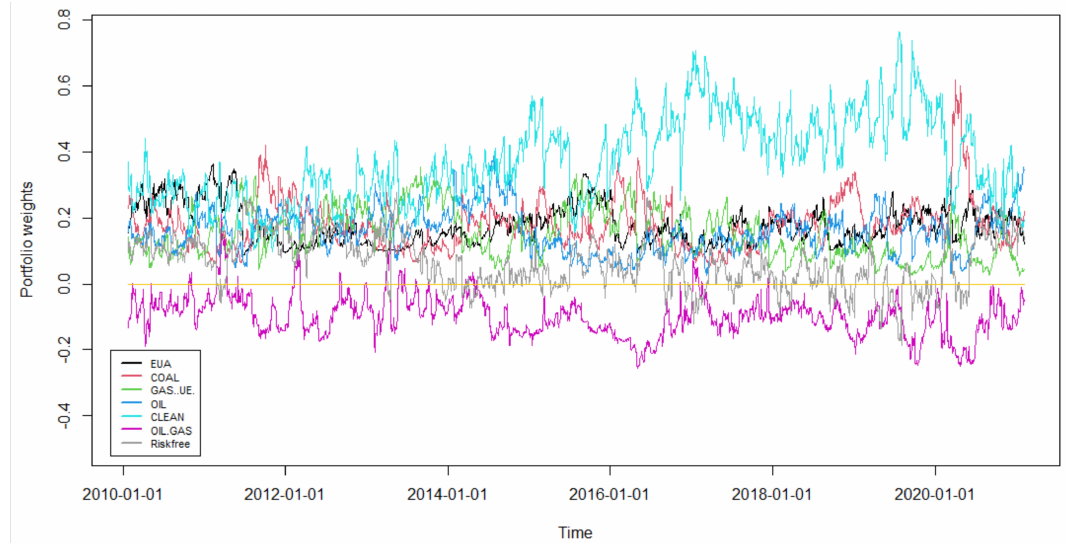
Figure 17. Evolution of the weights of the optimal portfolio composed by fossil fuels, energy stocks, EU allowances and a risk-free